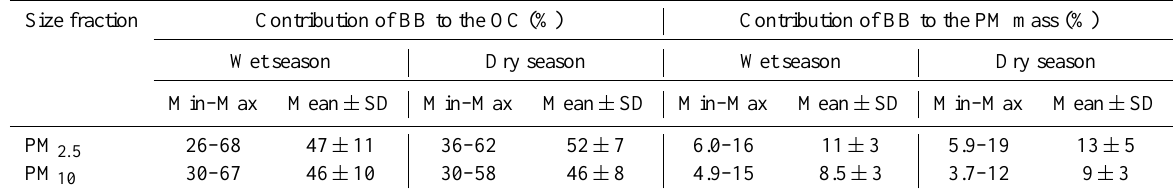
Table 3. Mean percentage contribution to the OC and PM mass from biomass/biofuel burning (BB) for the PM 2 . 5 and PM 10 during 2011 wet and dry season campaigns in